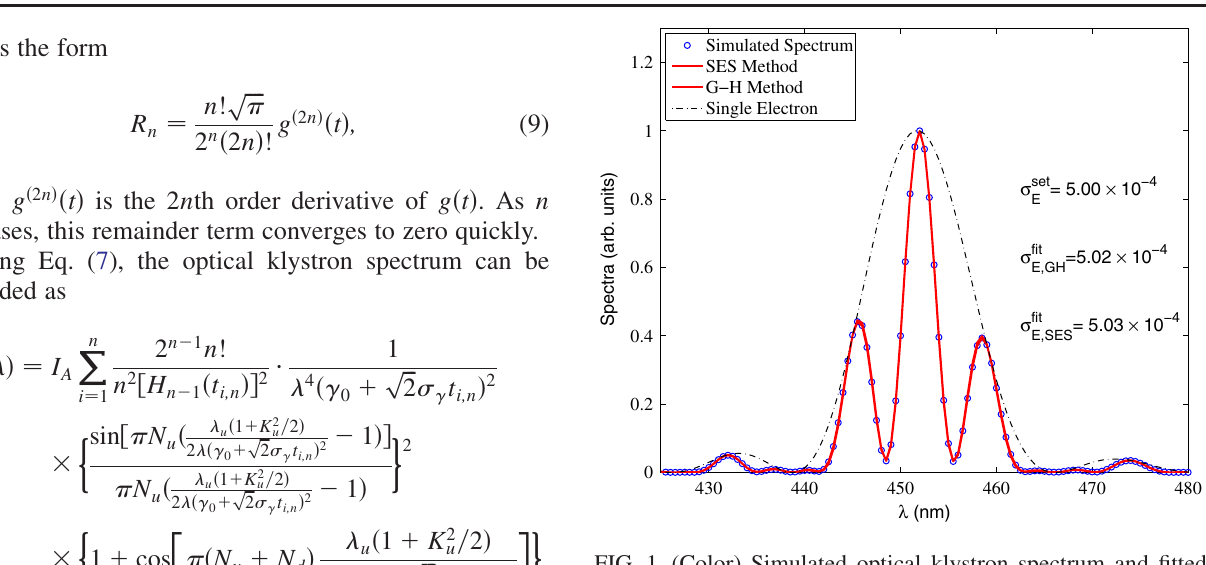
FIG. 1. (Color) Simulated optical klystron spectrum and fitted curves with both G-H and SES methods. The simulated spectrum ¼ 31 , (cid:1) set E ¼ 5 : 00 (cid:2) 10 (cid:1) 4 , and (cid:3) ¼ 1 nm ; is generated with N d x the other beam parameters are listed in Table I. The fitted curve using the G-H method and the fitted curve using the SES method are indistinguishable and both agree well with the simulated ¼ 33 ) with a mono- spectrum. A single undulator spectrum ( N u energetic beam is also shown as an expected envelope of the optical klystron spectrum when the energy spread is small.